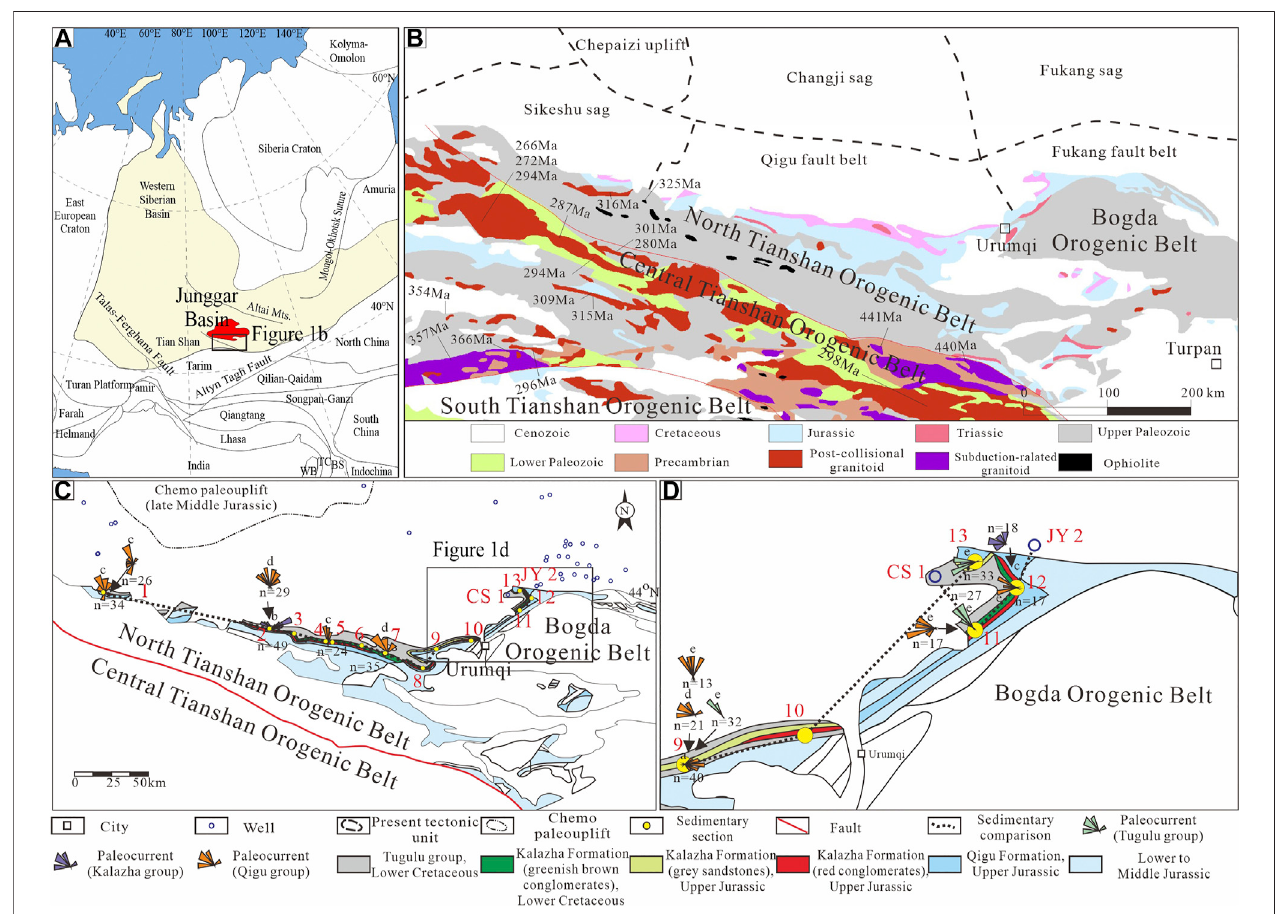
FIGURE 1 | (A) Simpli fi ed tectonic map of Asia, modi fi ed from Ma (2002). The light yellow area shows the location of the Central Asia Orogenic Belt. BS-Baoshan Block; TC-Tengchong Block; WB-West Burma Block; (B) geological map of the Tianshan and Bogda Orogenic Belts. The age data are provided in Supplementary MaterialS2 (C,D) stratigraphicdistributionandpaleocurrentsoftheUpperJurassicandLowerCretaceousinthesouthernJunggarBasin.1.Sikeshusection; 2.Manasi section; 3. Qingshuihe River section; 4. Taxihe River section; 5. Queergou section; 6. Hutubi River section; 7. Jiangong mine section; 8. Dongwozi section; 9. Toutunhe River section; 10. Wangjiagou section; 11. Baiyanggou section; 12. Shuimohe section; 13. Dahongshan section. The paleocurrents are from the following sources: a. Fang et al., 2019; b. Hendrix et al., 1992; c. Zhou, 2020; d. Zhou et al., 2019; and e. Wang et al., 2007. The Upper Jurassic to Lower Cretaceous strata thickness is exaggerated for several kilometers to better show the stratigraphic distribution. The boundaries of paleouplift in the late Middle Jurassic refers to He et al. (2008).